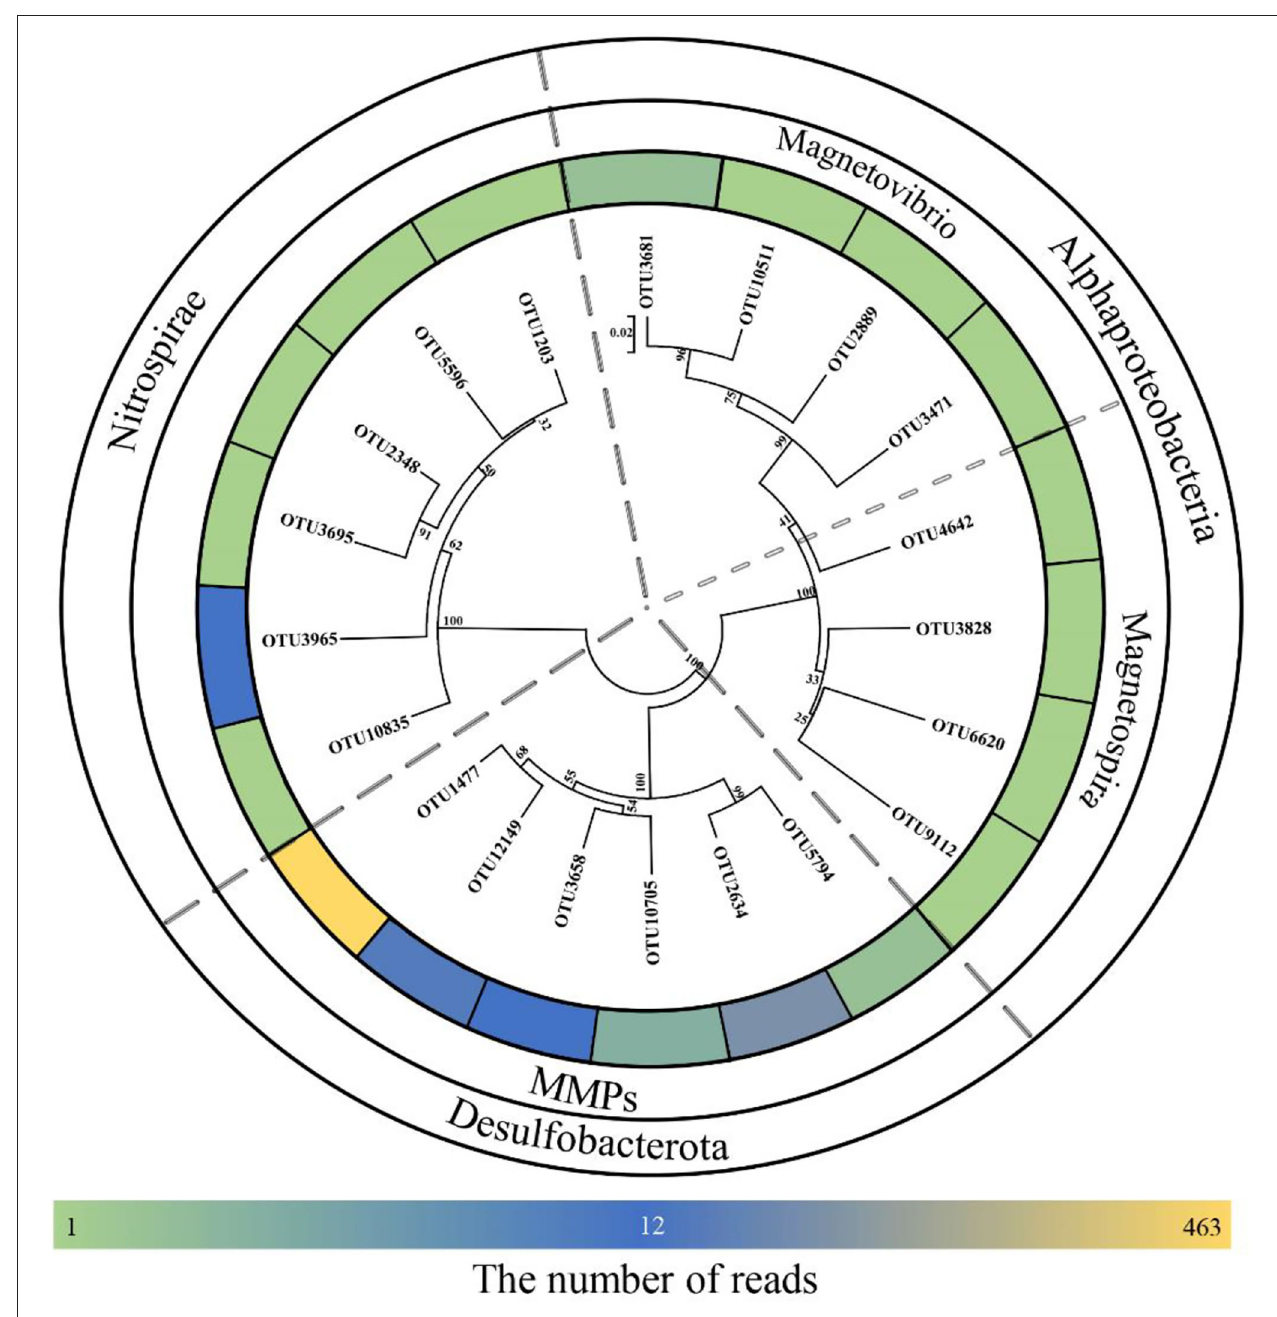
FIGURE 1 | Neighbor-joining tree for environmental magnetotactic bacteria based on 16S rRNA gene sequences. Scale bar: 0.02.